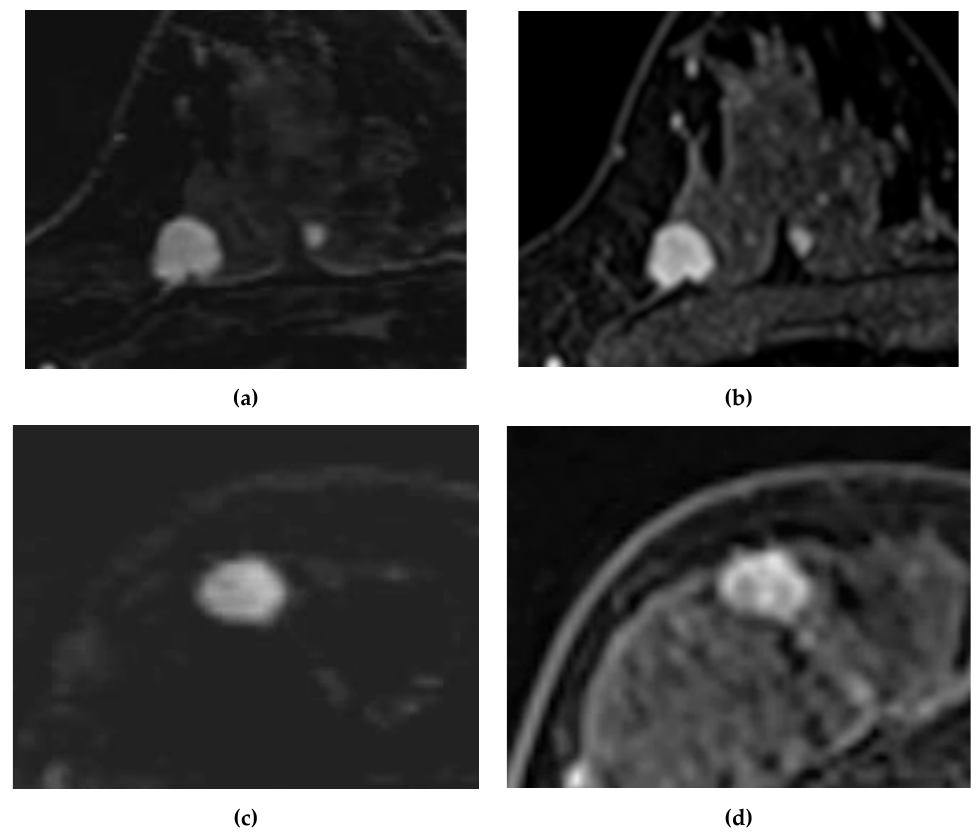
Figure 3. Cases showing agreements and discrepancies in morphology between UF DCE-MRI and conventional DCE-MRI. Case 1: A 49-year-old woman with invasive ductal carcinoma. Case 2: A 43-year-old woman with invasive ductal carcinoma. ( a ) UF DCE-MRI of Case 1. ( b ) Conventional DCE-MRI of Case 1. ( c ) UF DCE-MRI of Case 2. ( d ) Conventional DCE-MRI of Case 2. Both images of Case 1 show the same morphology with a circumscribed margin and homogeneous enhancement. However, ( c ) shows a circumscribed margin and homogeneous enhancement, whereas ( d ) shows an irregular margin and rim enhancement; ( c ) would likely result in a diagnosis of a benign lesion.